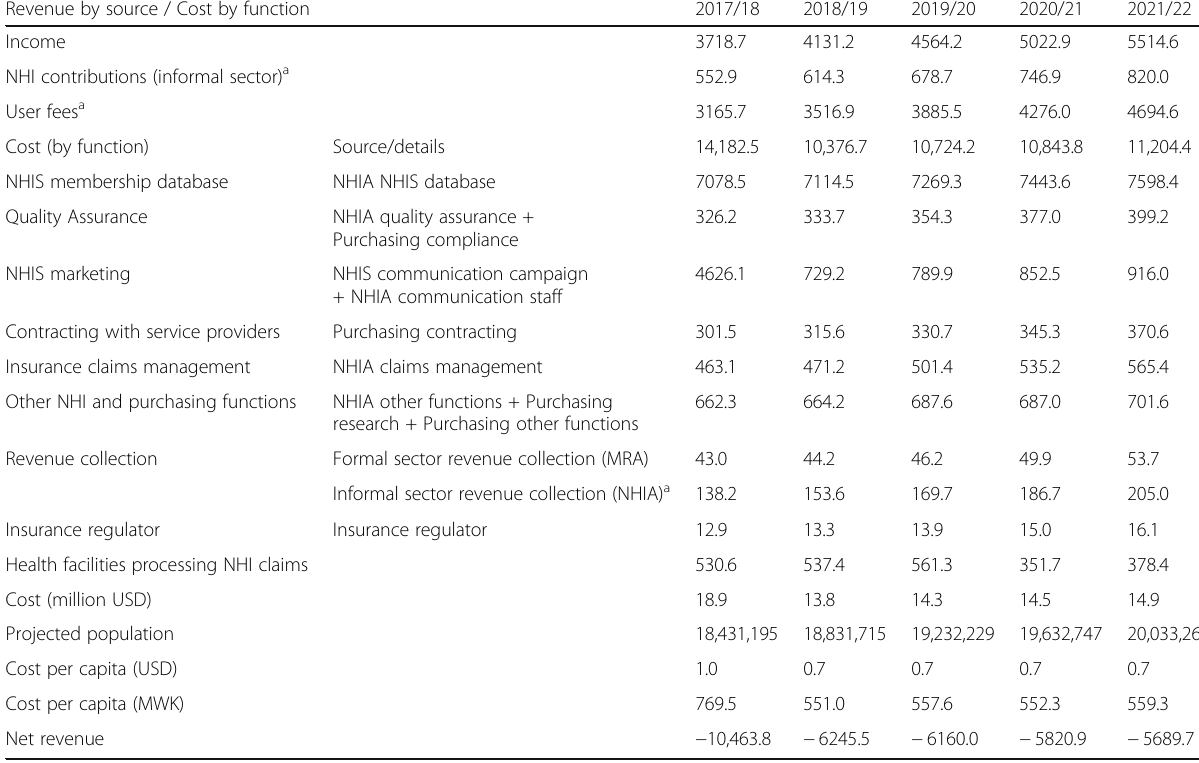
Table 1 Total revenue, administrative costs and net effects of NHI Scenario (MWK million) Revenue by source / Cost by function